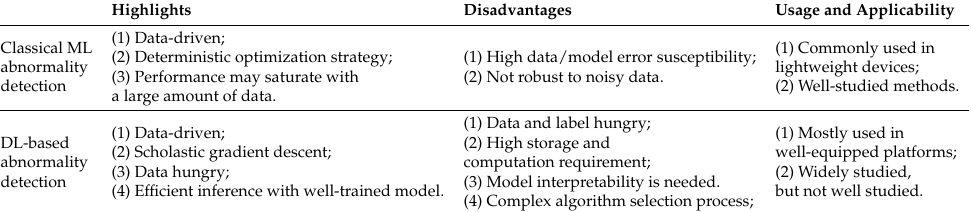
Table 6. Comparison of ML- and DL-based abnormality